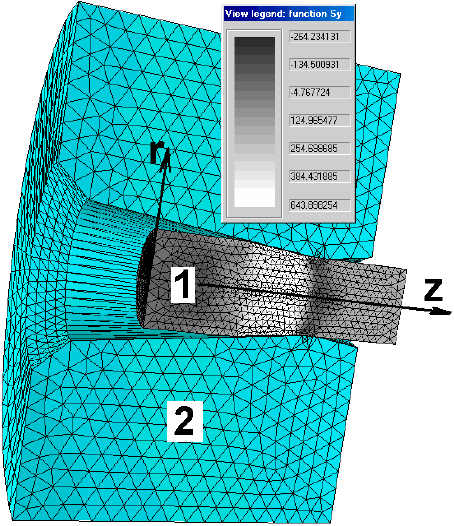
Figure 8. An example of a generated finite element mesh for drawing material (1) and die (2) and an example of a stress field distribution along the z -axis, marked in the computer program as σ y.